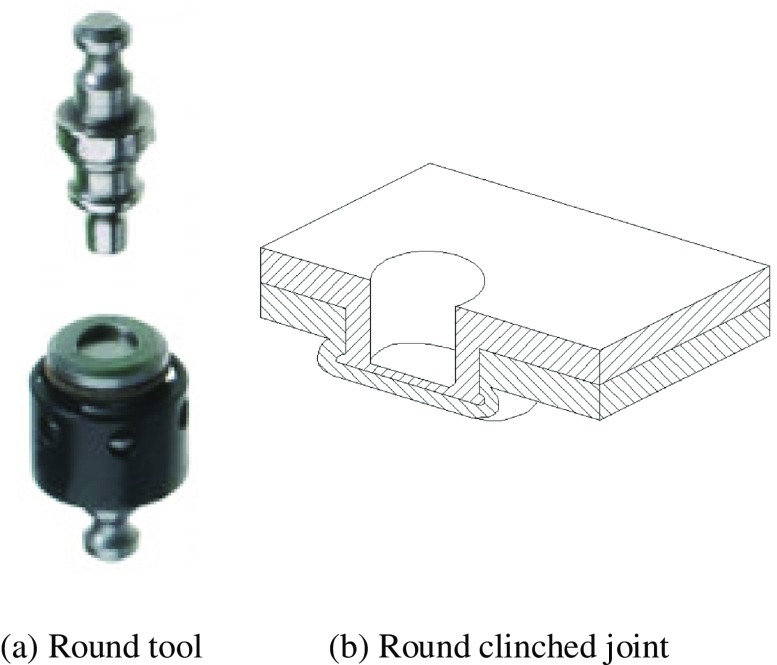
Round clinching.